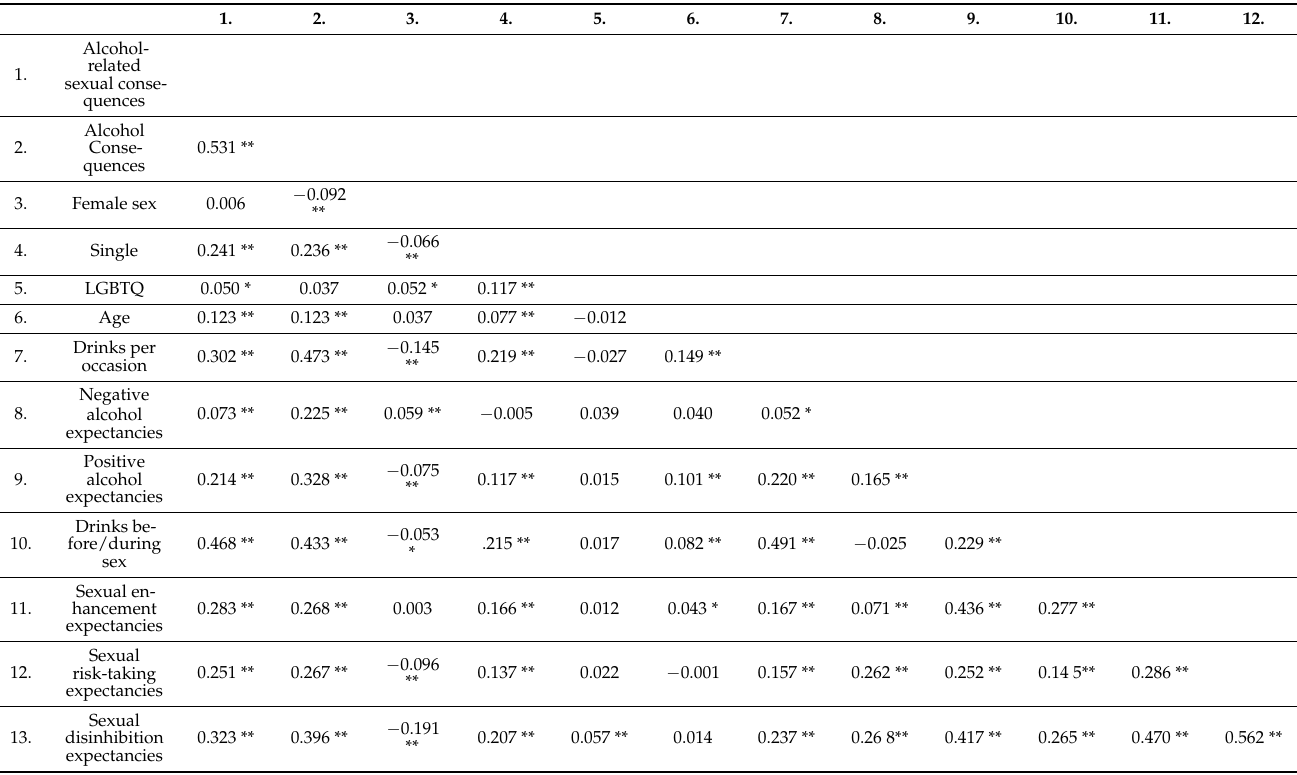
Table A3. Bivariate correlations for the variables included in the binomial regression